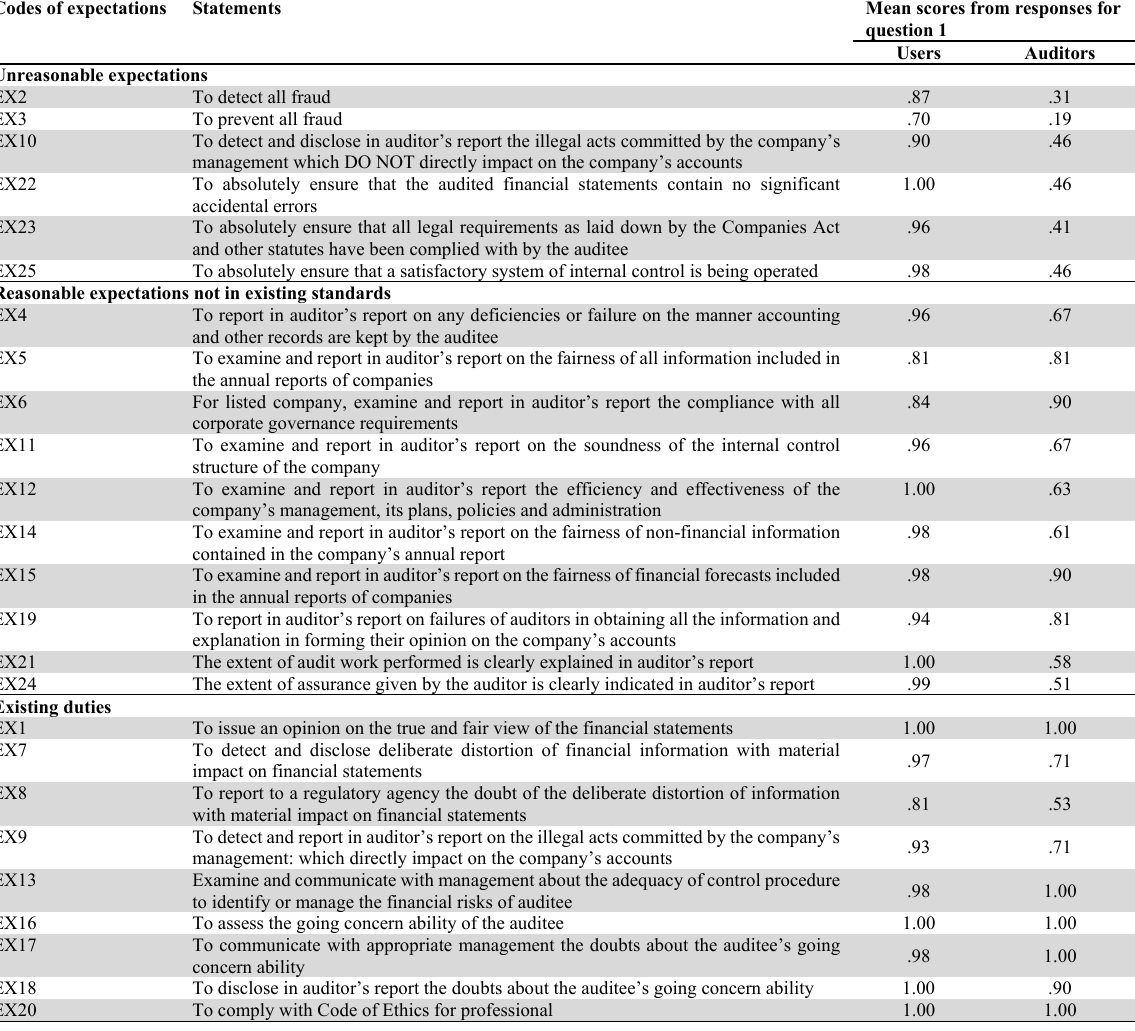
Mean scores from responses for question